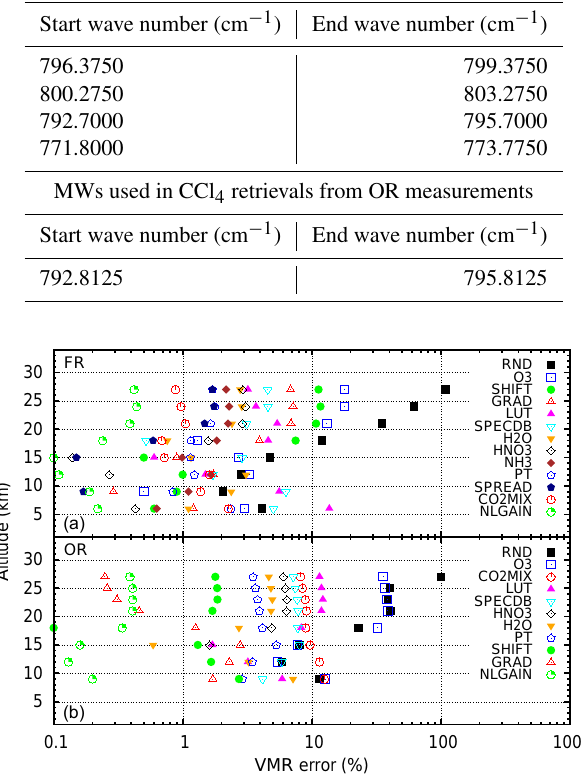
Figure 2. Main error components of the individual retrieved CCl 4 VMR profiles from FR (a) and OR (b) nominal MIPAS measure-